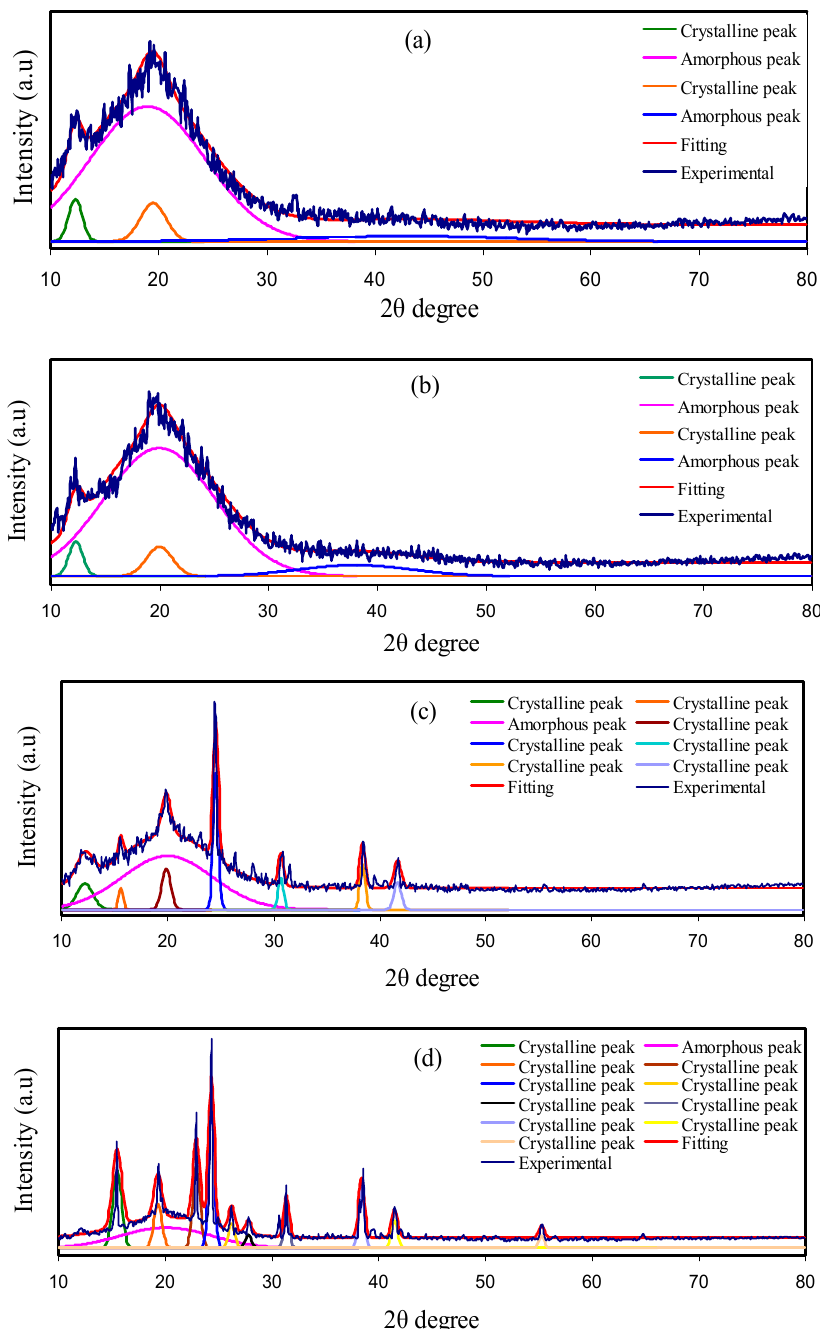
Figure 1. X-ray diffraction (XRD) pattern for ( a ) CSPEH1, ( b ) CSPEH2, ( c ) CSPEH3 and ( d ) CSPEH4 polymer blend electrolytes. Table 1. The degree of crystallinity from deconvoluted XRD analysis.